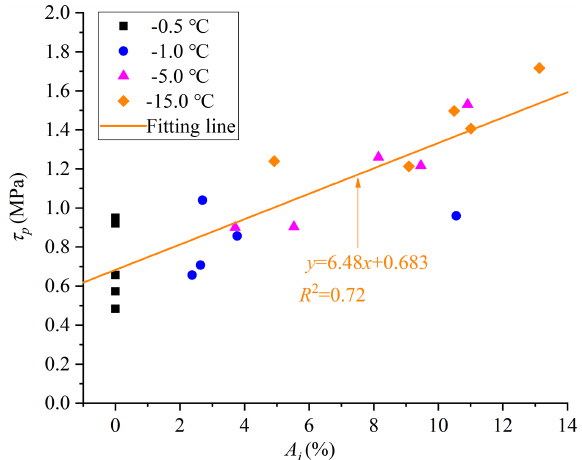
Figure 10. Peak shear strength linearly increases with increas- ing aggregation areas of rupture ice. Experimental conditions: